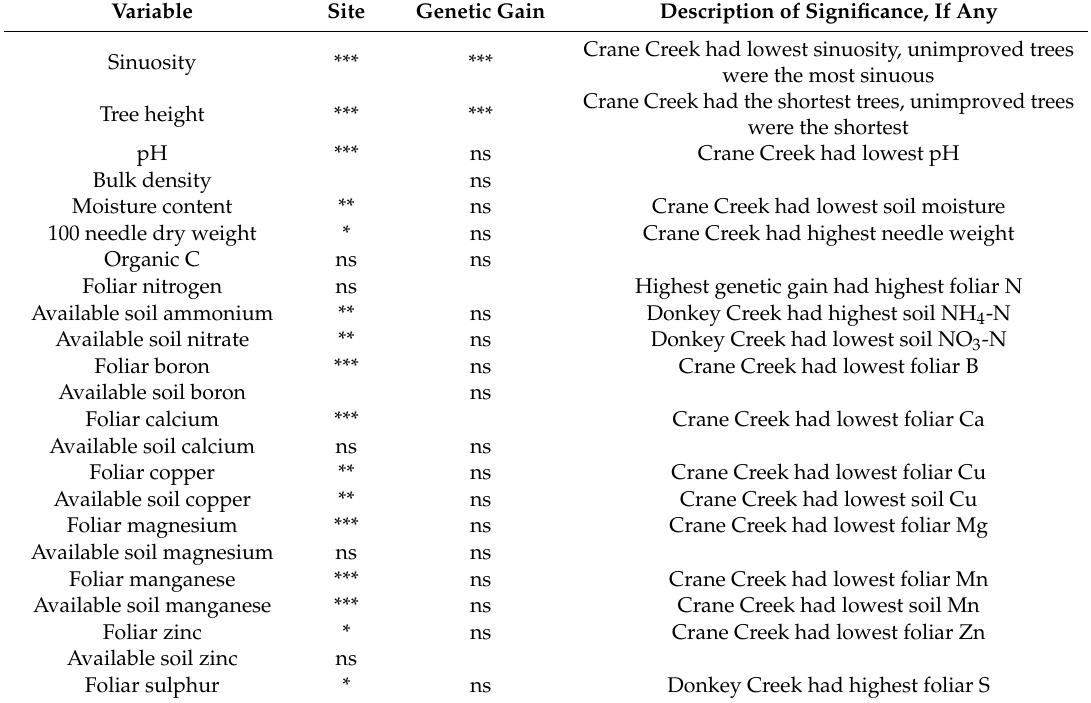
Table 2. ANOVA table for all measured variables.